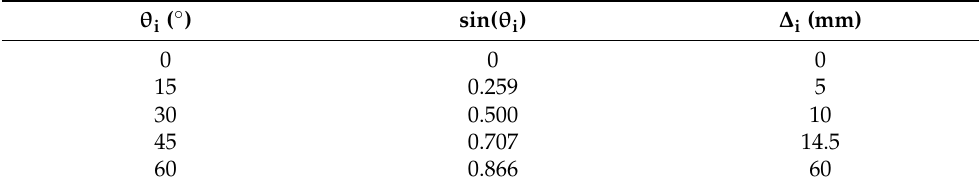
Figure 8. Temperature profiles with fitting curves by using the moving average for different angles of incident waves ( θ = θ i ). Table 1. Deduced values of the shifts ( Δ i ) from the fitted temperature profiles.